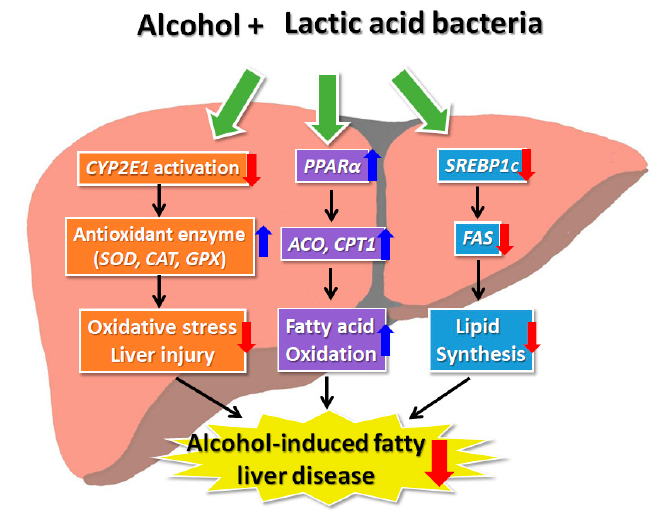
Figure 6. Lactic acid bacteria as probiotics exert a hepatoprotective effect by modulating antioxidant and lipid metabolism in ethanol-induced HepG2 cells.